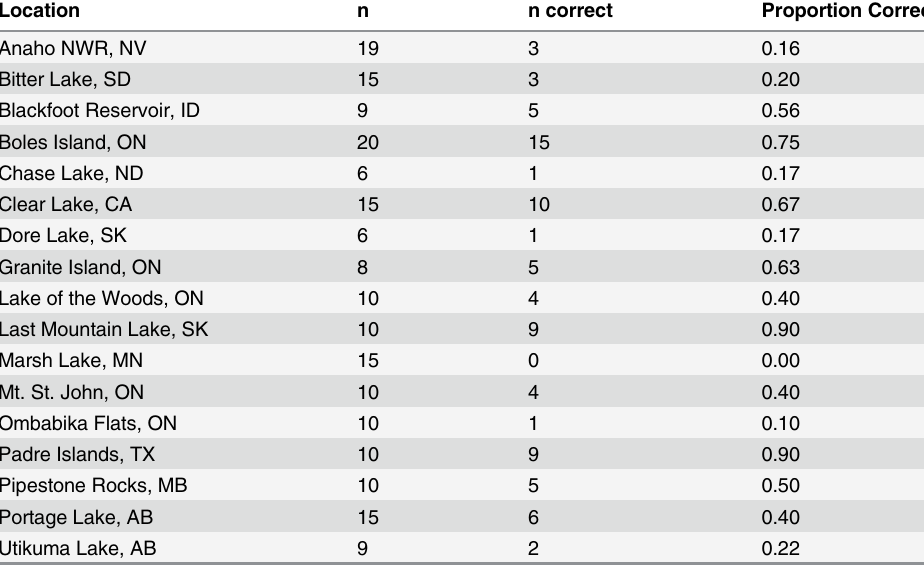
Table 1. Cross-validation Success